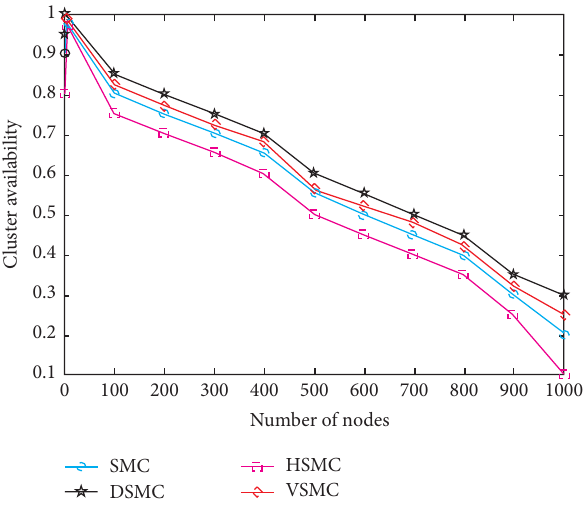
memory cluster system based on availability and bandwidth.